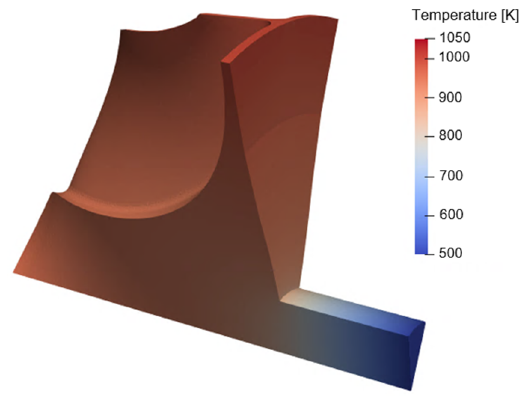
Figure 20. Solid temperature distribution with rotor experiencing convective loading from the exhaust gases and shaft cooling (baseline geometry).